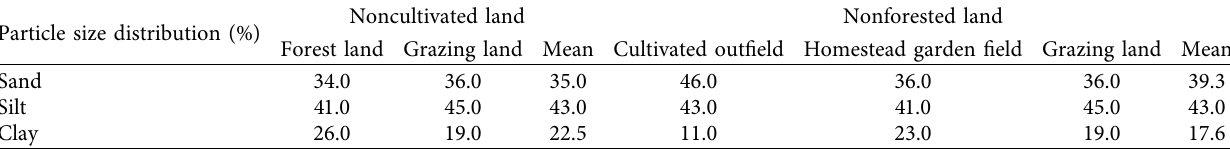
Table 1: Mean values of particle size of soils as affected by the noncultivated and nonforested parts of the experimental area. Particle size distribution (%)